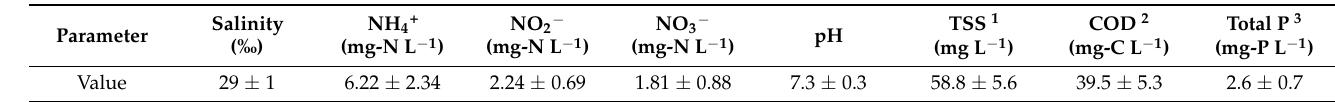
Table 2. Physicochemical characteristics of the RAS WW. Values show the average and standard deviation during the